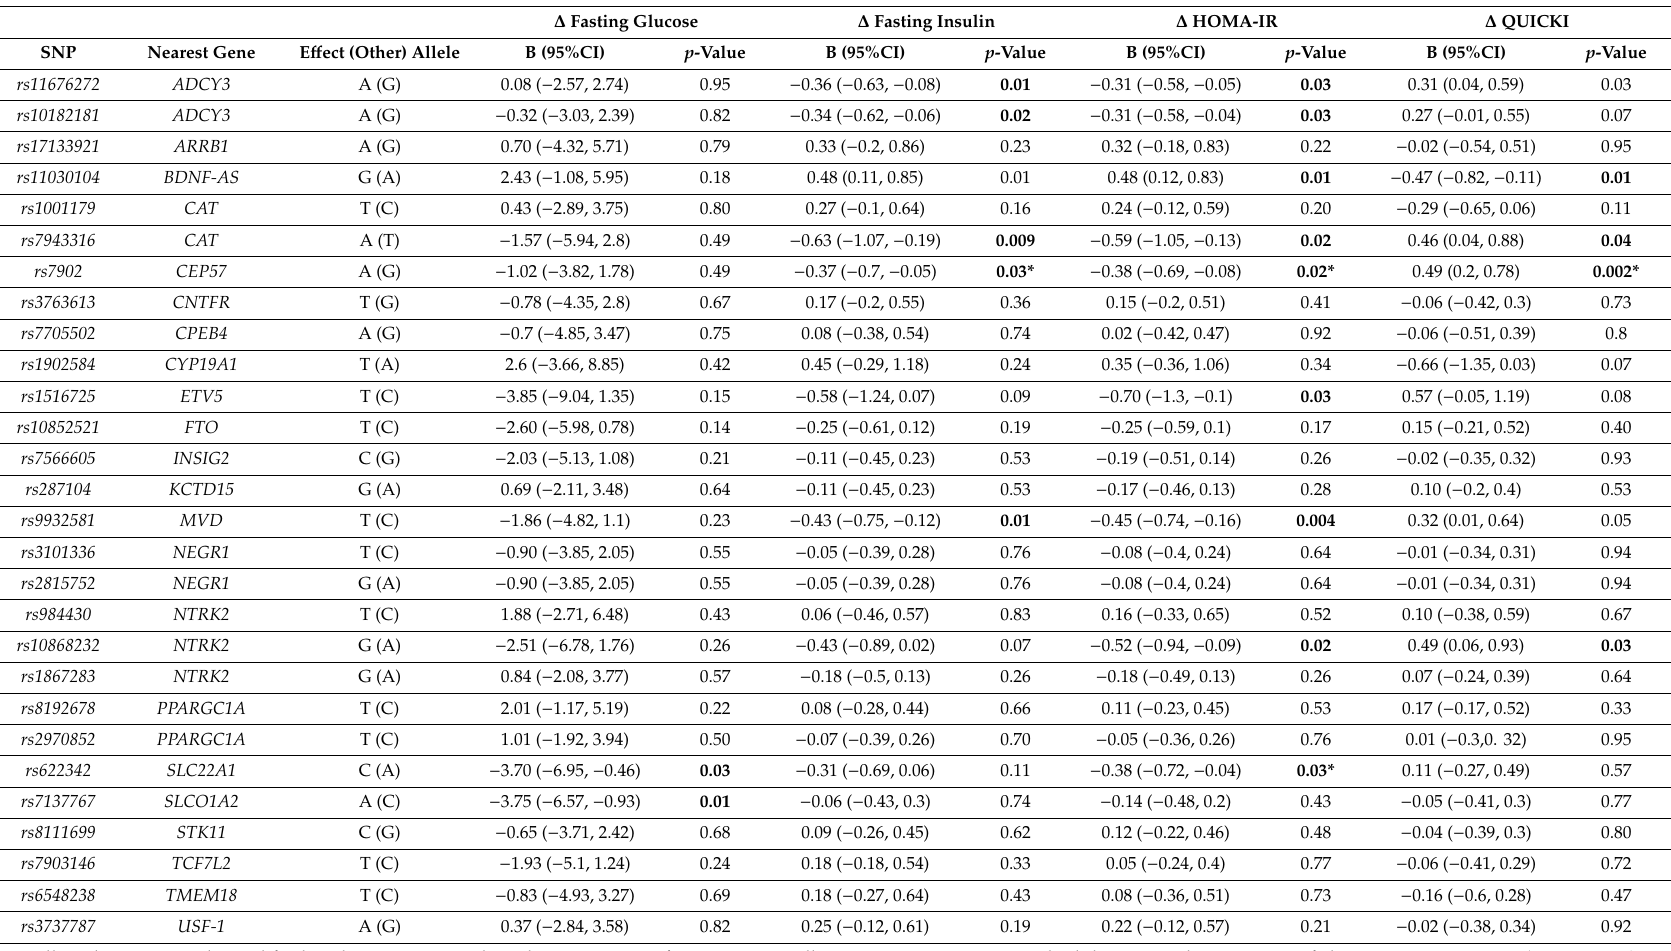
Table 1. Summary of association data for the 28 selected common variants in glucose metabolism